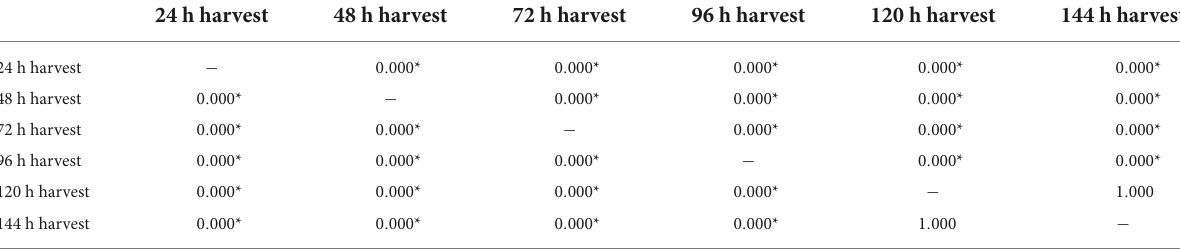
TABLE 4 Pairwise comparison of the harvests for flavonoids by Scheffe post hoc test.